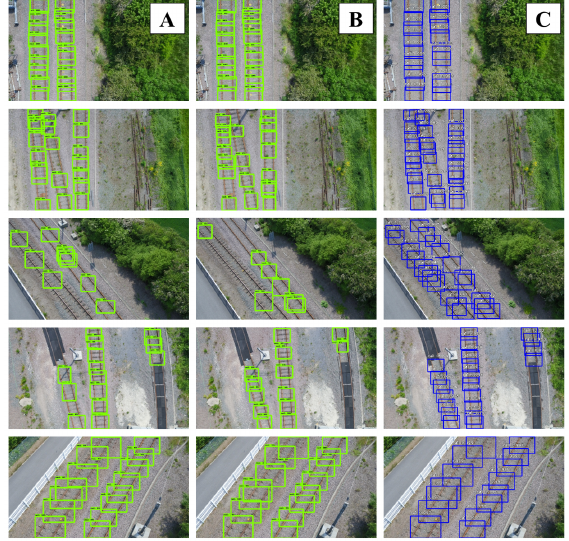
Figure 7: Visual inspection of computed proposals for A) Inception-Resnet, B) Resnet and C) Retinanet. In general, oblique imagery performed worse than directly nadir imagery. This is likely due to a larger number nadir imagery in the training